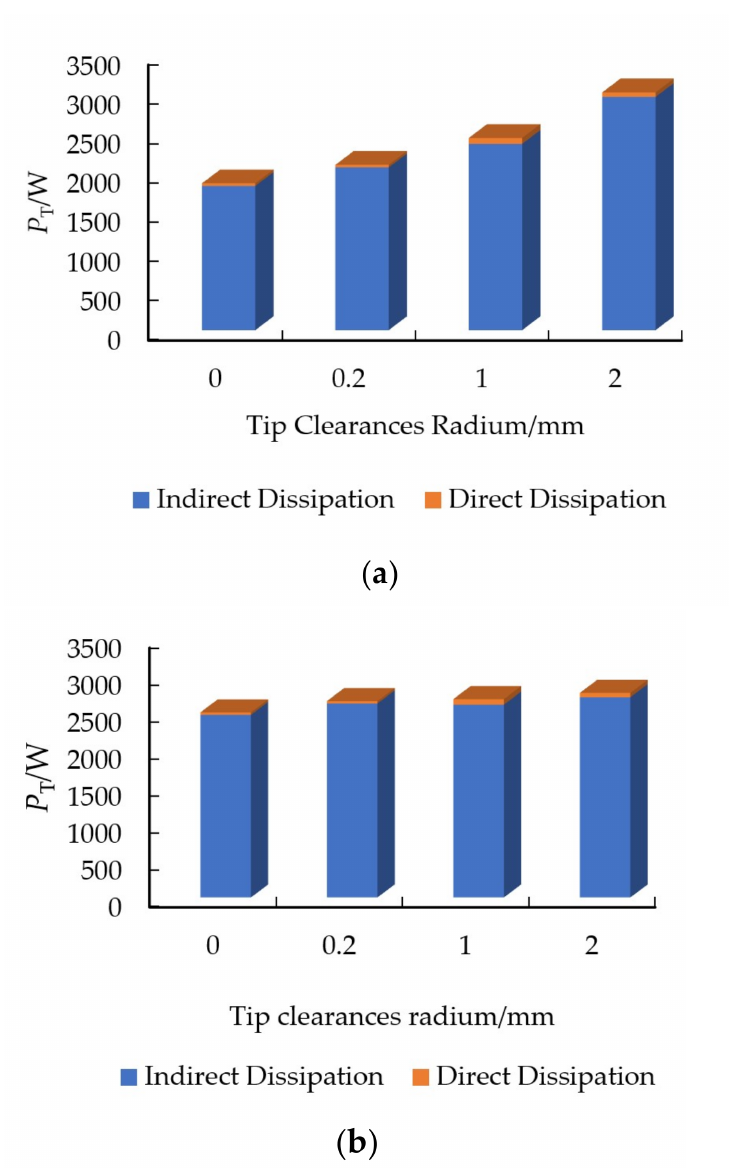
Figure 11. Comparison of direct dissipation and turbulence dissipation; ( a ) Pump condition; ( b ) Turbine